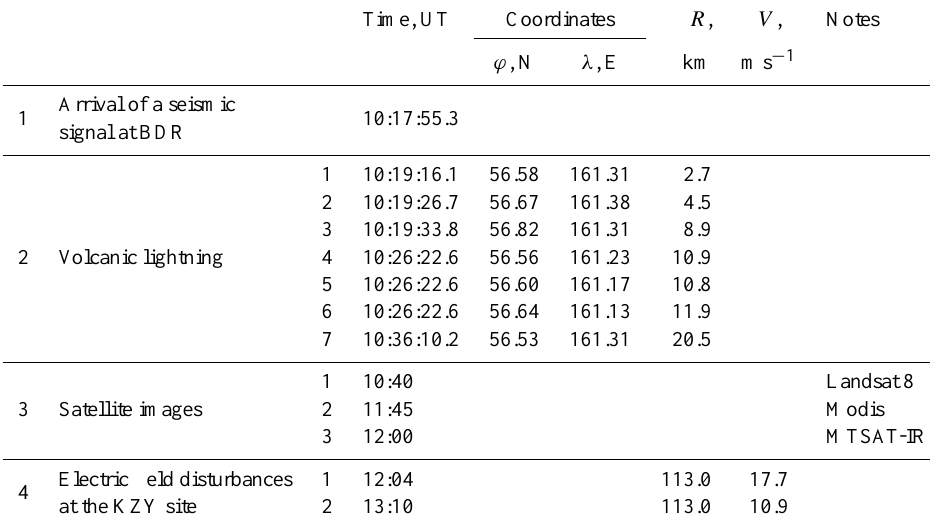
Table 1. Chronology of observations of Shiveluch volcano eruption on 16 November 2014.